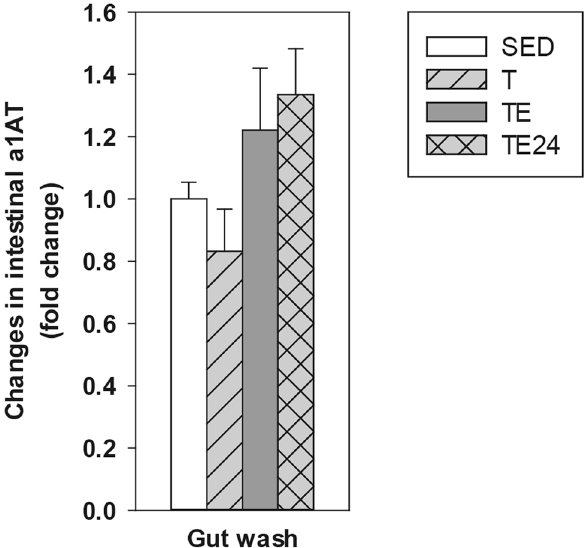
Figure 4. Changes in gut wash alpha-1-antytripsin (a1AT) concentration compared to the sedentary group. SED sedentary rats, T trained rats, TE T rats immediately after a final exhaustion test, TE24 TE rats 24 h after the final exhaustion test. Data are expressed as mean ± standard error (n =